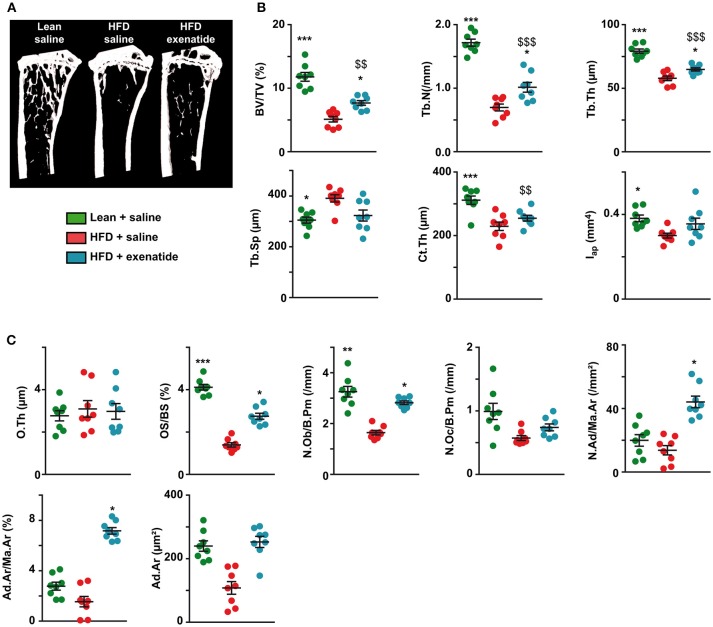
Effects of HFD-induced diabetes and treatment with exenatide on trabecular and cortical bone microarchitectures. (A) Three-dimensional models of tibias were reconstructed and highlight differences in trabecular bone network. (B) Trabecular microarchitecture parameters determined at the proximal tibia and cortical microarchitecture parameters measured at the midshaft femur. BV/TV: trabecular bone volume, Tb.N: trabecular number, Tb.Th: trabecular thickness, Tb.Sp: trabecular spacing, Ct.Th: cortical thickness and Iap: cross-sectional moment of inertia about the anteroposterior axis. *p < 0.05, **p < 0.01, ***p < 0.001 vs. HFD + saline. $p < 0.05, $$p < 0.01, $$$p < 0.001 vs. Lean + saline. Values are means ± SEM for 8 mice. (C), Histomorphometrical parameters measured at the proximal tibia. O.Th, osteoid thickness; OS/BS, osteoid surface; N.Ob/B.Pm, number of osteoblasts; N.Oc/B.Pm, number of osteoclasts; N.Ad/Ma.Ar, adipocyte number; Ad.Ar/Ma.Ar, bone marrow adiposity volume; Ad.Ar, adipocyte area. *p < 0.05, **p < 0.01, ***p < 0.001 vs. HFD + saline. $$p < 0.01, $$$p < 0.001 vs. Lean + saline.